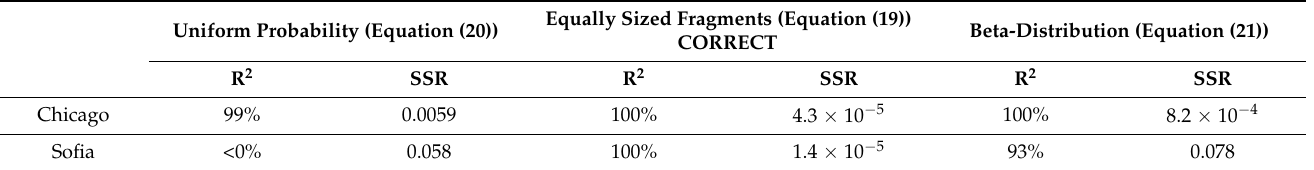
Table 4. Sensitivity of the different methods to the choice of f . R 2 and SSR between validation DSD and predicted DSD, making different assumptions of m , when using the methods to estimate the fragmentation rate. The validation data was created using equally sized fragment f (